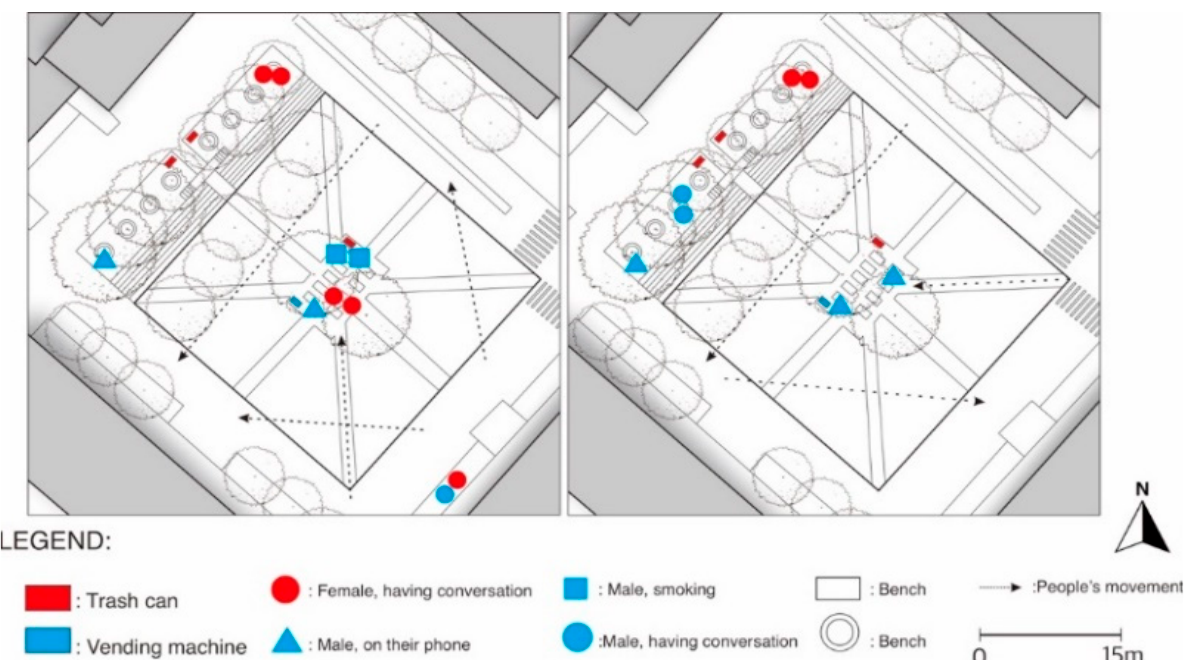
Figure 4. Behavioral map of people engaged in various activities during a weekday at Democratic Plaza (on the left: at 6 p.m., on the right: at 2 p.m.). Plaza (on the left: at 6 p.m., on the right: at 2